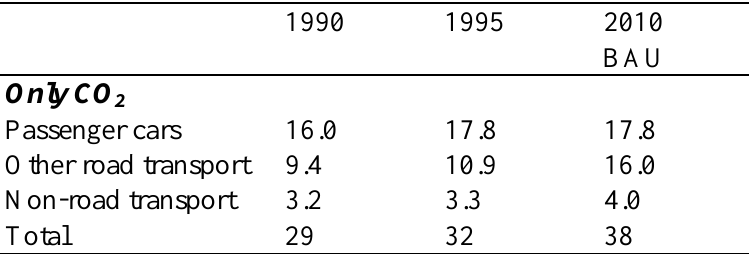
Table 1 Greenhouse gas emissions in the Netherlands in Mtonne CO